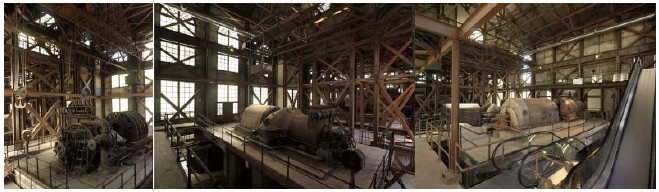
Figure 14. Less intervention and the visibility of structure from